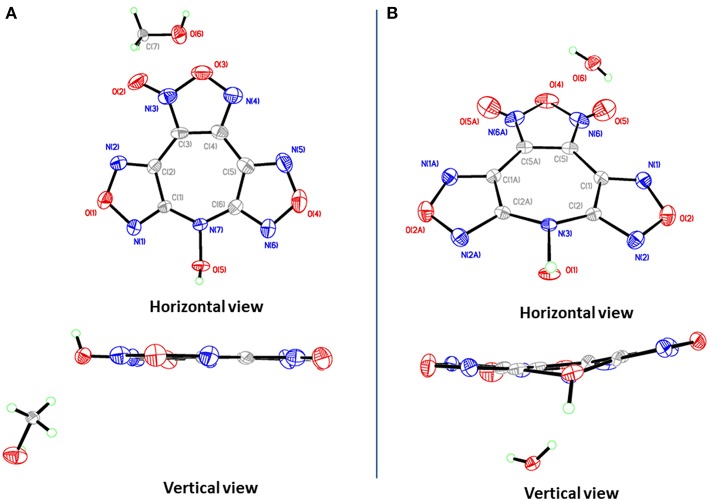
Single-crystal X-ray structures of 4·MeOH (A) and 4·H2O (B).